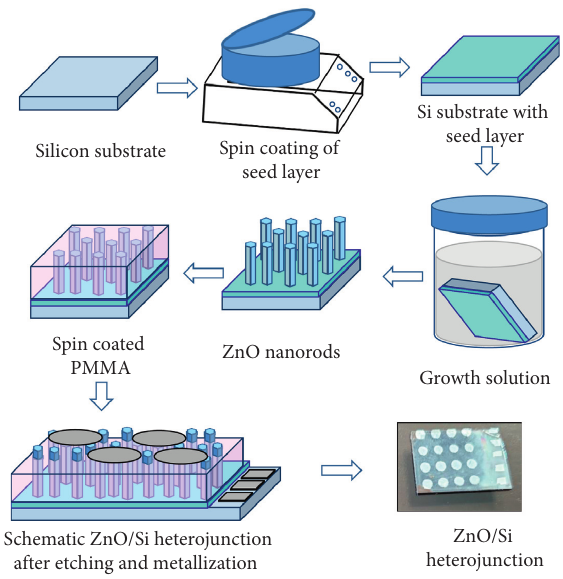
Figure 1: Step-by-step growth and device fabrication